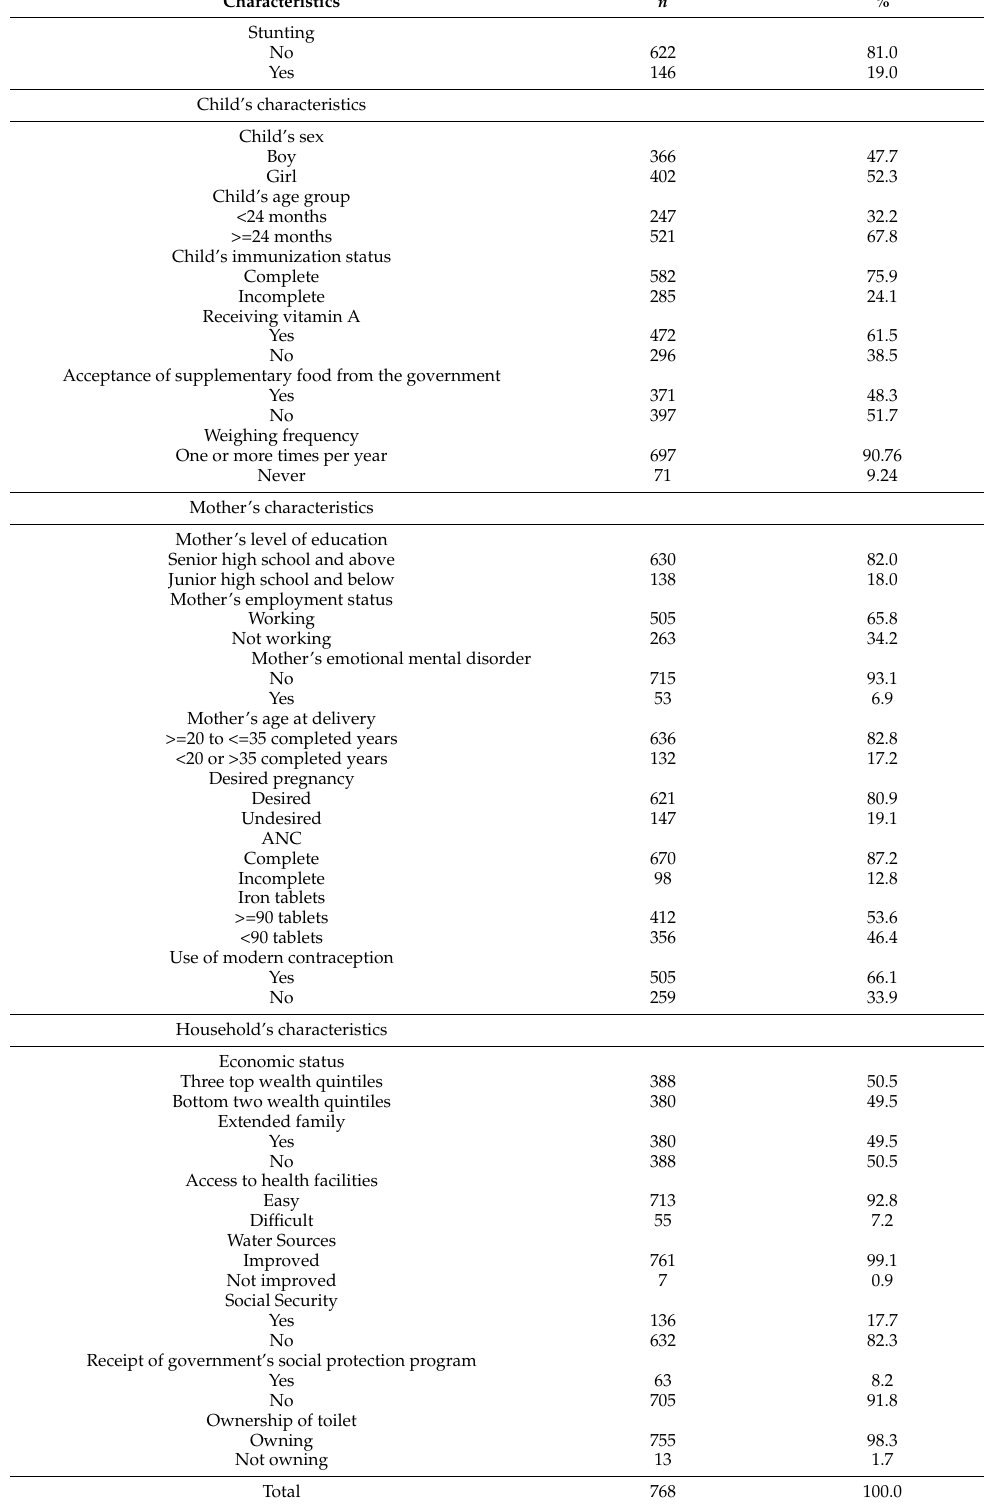
Table 1. Descriptive characteristics of children aged 6–59 months in Bali Province,